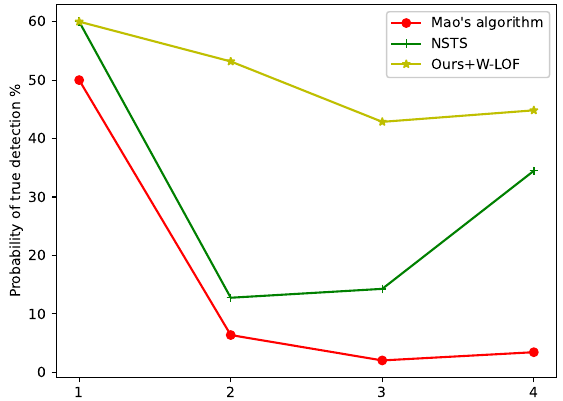
Figure 13. Comparison of the probability of the true detection. One to four are star images in Figure 11 (1–4).